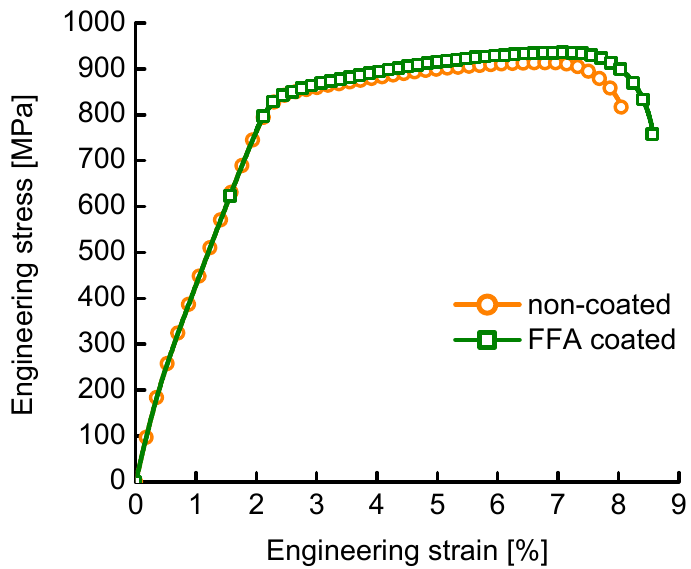
Figure 7. Influence of FFA coating on mechanical properties of NiCrMoV steel in 0.01 M acetic acid at 90 °C ( ε(cid:4662) = 10 (cid:2879)(cid:2874) s (cid:2879)(cid:2869) ).